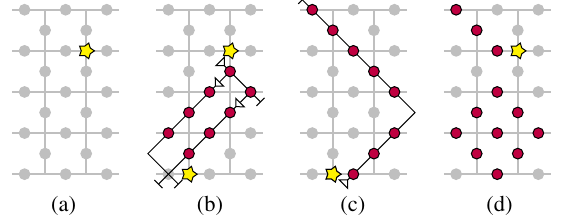
FIG. 23. Example of Y -type destabilizer construction for a coprime code. (a) Single syndrome location. (b) A partial recovery operator is constructed by applying Y operators, from below the syndrome location along a diagonal to any boundary, then from that diagonal along perpendicular diagonals, until the bottom boundary is encountered. (c) Residual recovery operators are constructed by applying Y operators, from right of each residual boundary syndrome location along a diagonal away, until a corner is encountered. (d) The destabilizer is a product of partial and residual recovery operators.